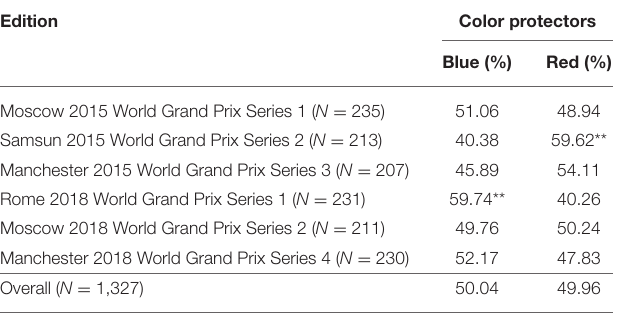
TABLE 2 | Percentage of winners wearing blue and red protectors in each WGPS.